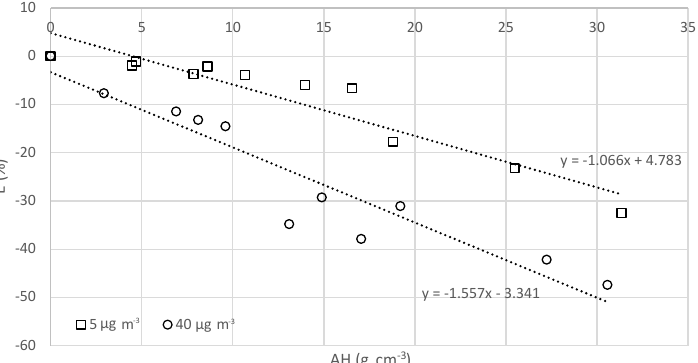
Figure 2. Relative differences in readings from the reference value of concentration as a function of the absolute humidity of the sample.